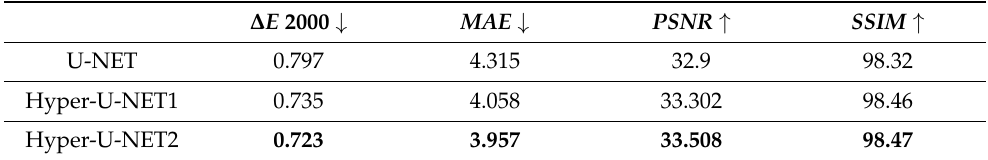
Figure 5. Loss function curve comparisons. Table 1. Results of the ablation experiments with three different models. The best results of each column are in bold.